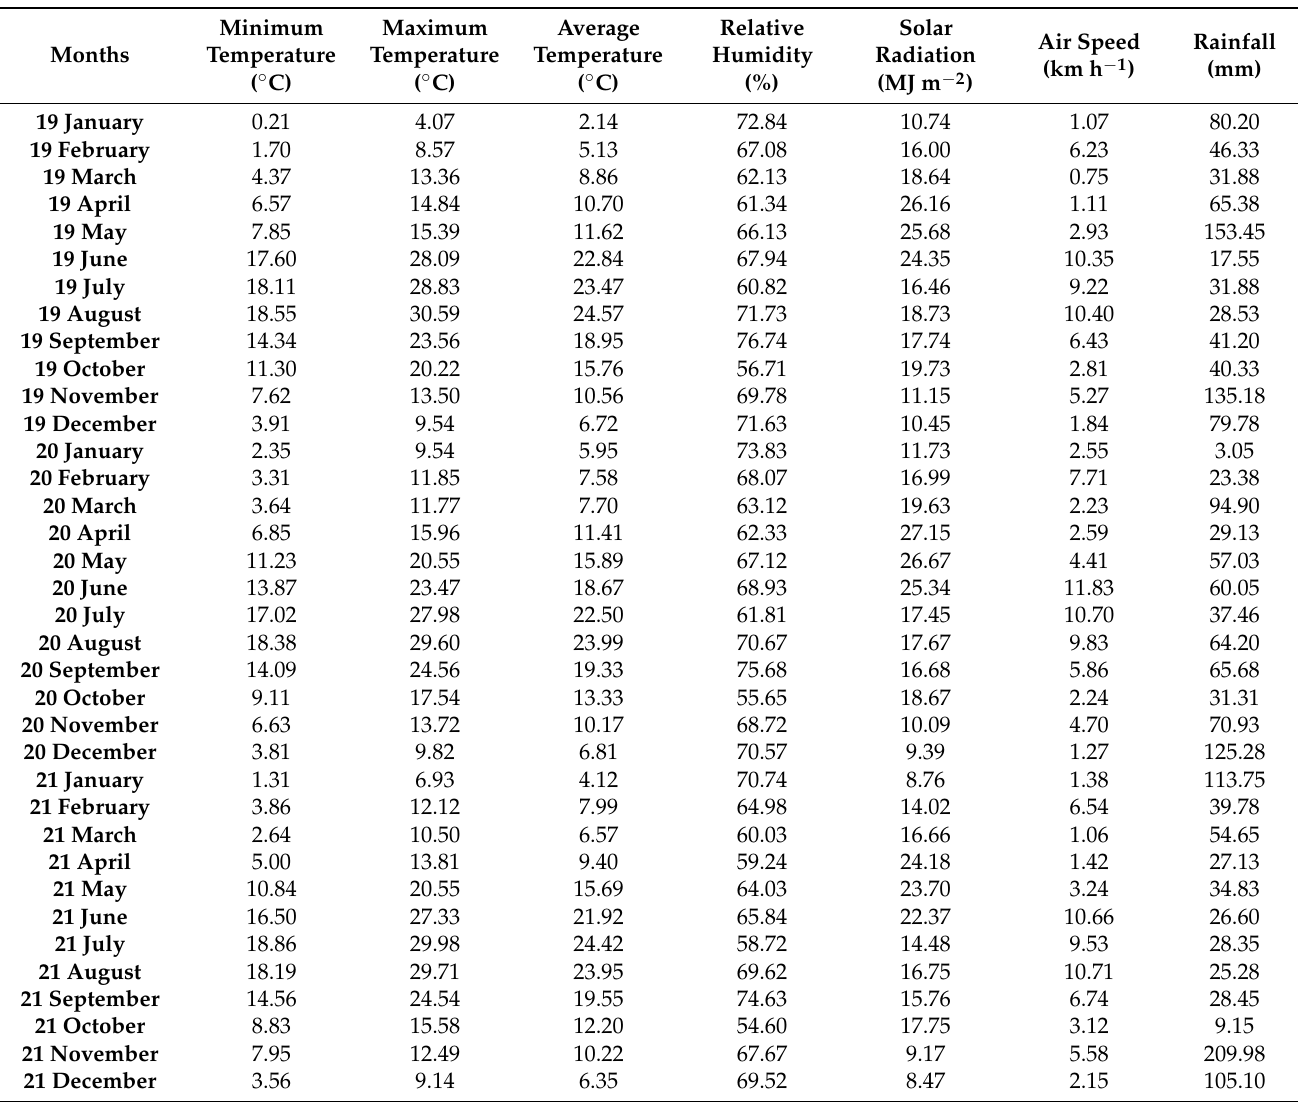
Table A1. Mean collected environmental parameters used for daily ETo estimation at Molise region